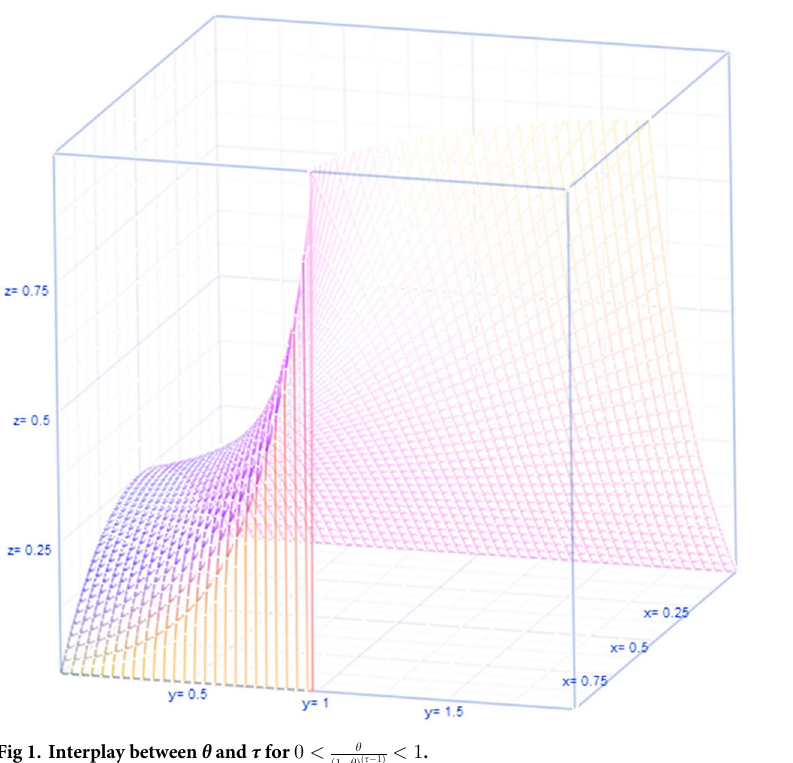
Fig 1. Interplay between θ and τ for 0